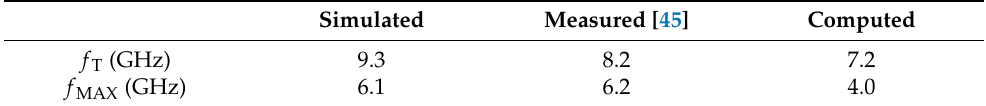
The simulated h 21 and MAG at the optimal bias point V GS = − 0.2 V, V DS = − 1.2 V, in-